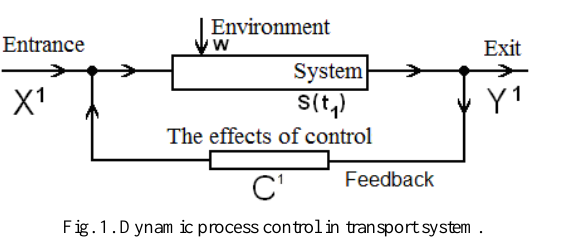
Fig. 1. Dynamic process control in transport